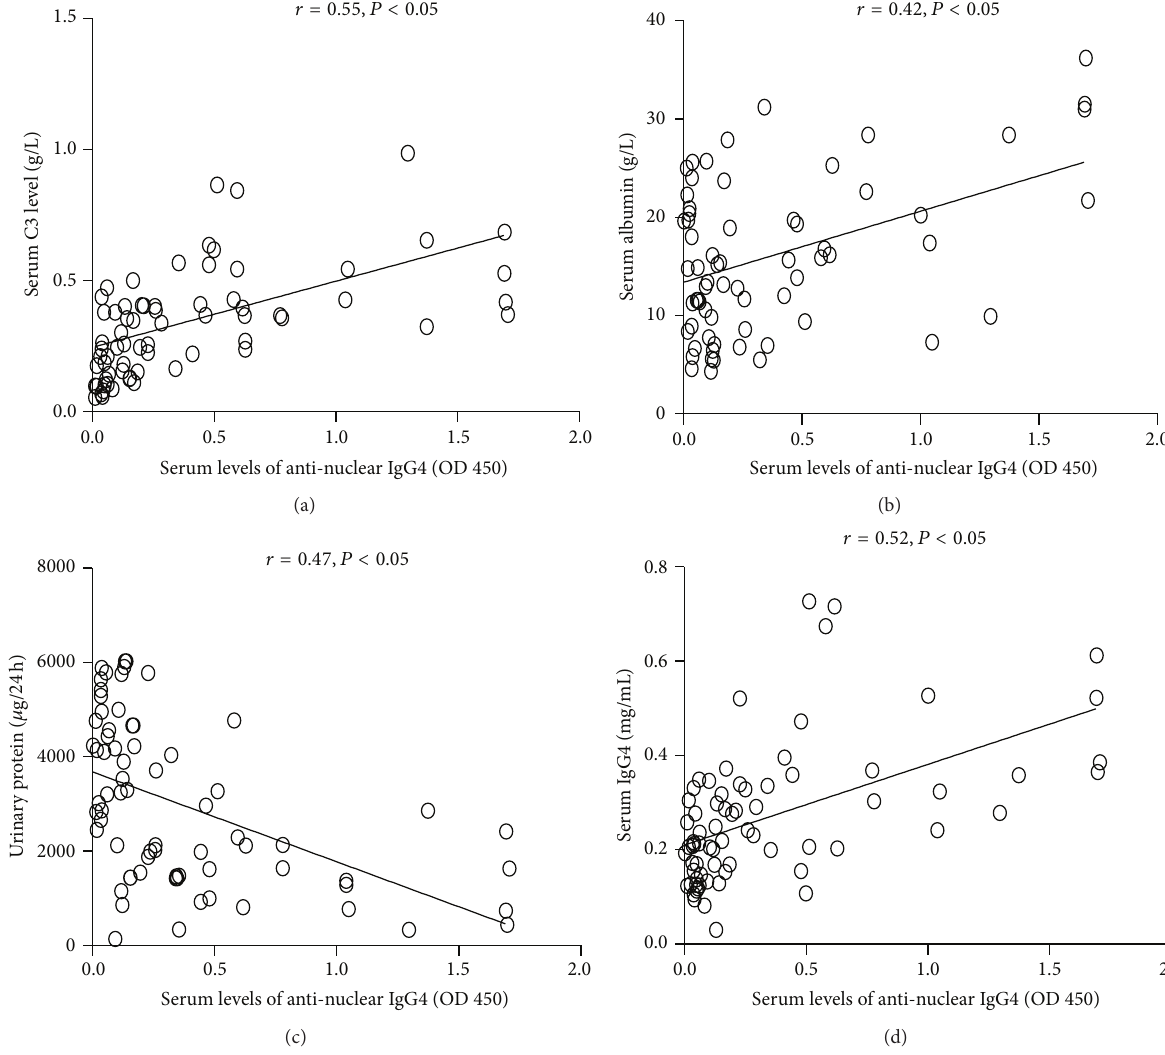
Figure 2: The correlations between serum levels of anti-nuclear IgG4 in SLE patients and clinical parameters. Detection of serum levels of IgG4 and anti-nuclear IgG4 was conducted by ELISA as described in Section 2. Serum levels of albumin, C3, Scr, SUA, and 24-hour urinary protein were analyzed using a commercial kit as described in Section 2.2. The correlations between serum levels of anti-nuclear IgG4 and serum levels of C3, albumin, total IgG4, and 24-hour urinary protein were analyzed using Spearman’s rank correlation coefficient. The 𝑃 value was considered statistically significant if it was less than 0.05. ( 𝑛 = 72 , newly diagnosed SLE patients).